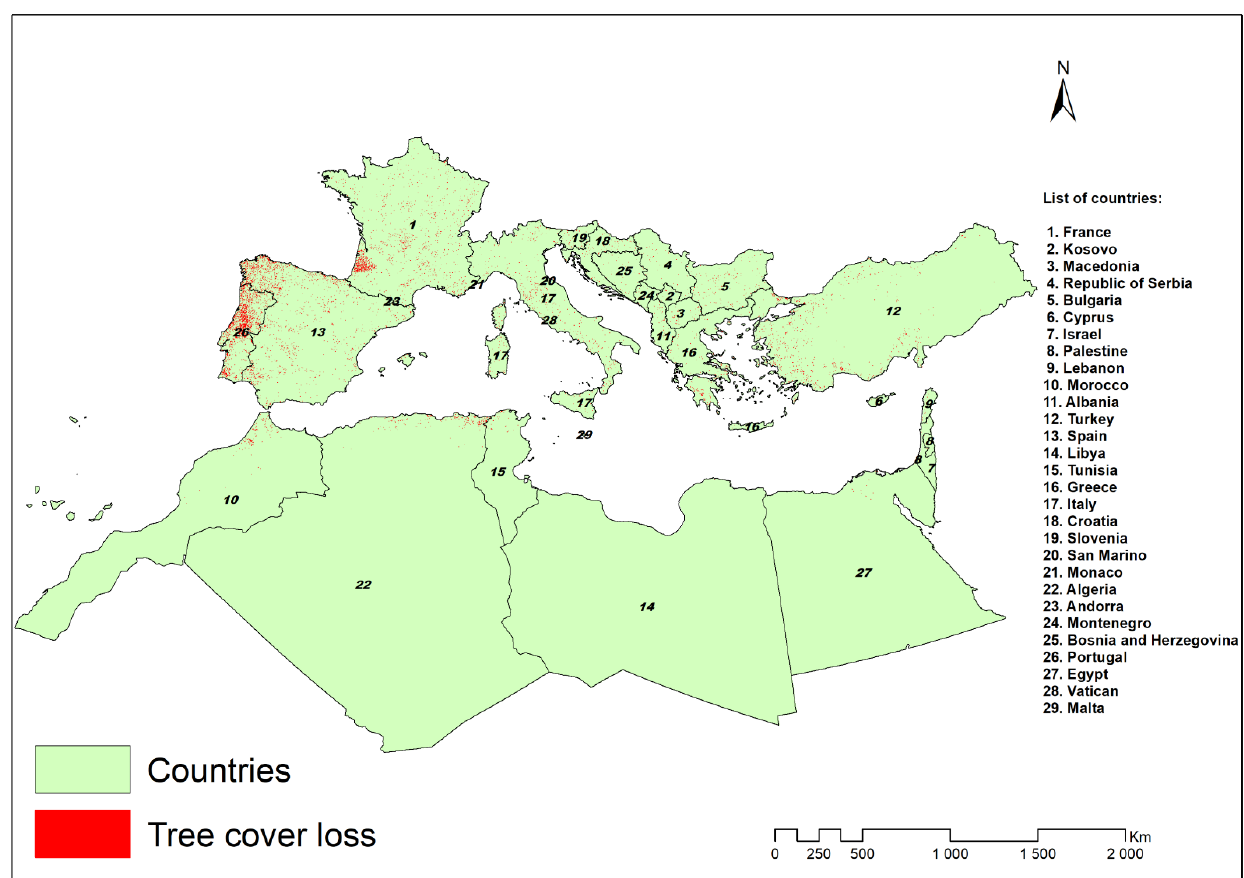
Figure 6. Spatial distribution of the tree cover loss areas in the Mediterranean Region (2001–2019).